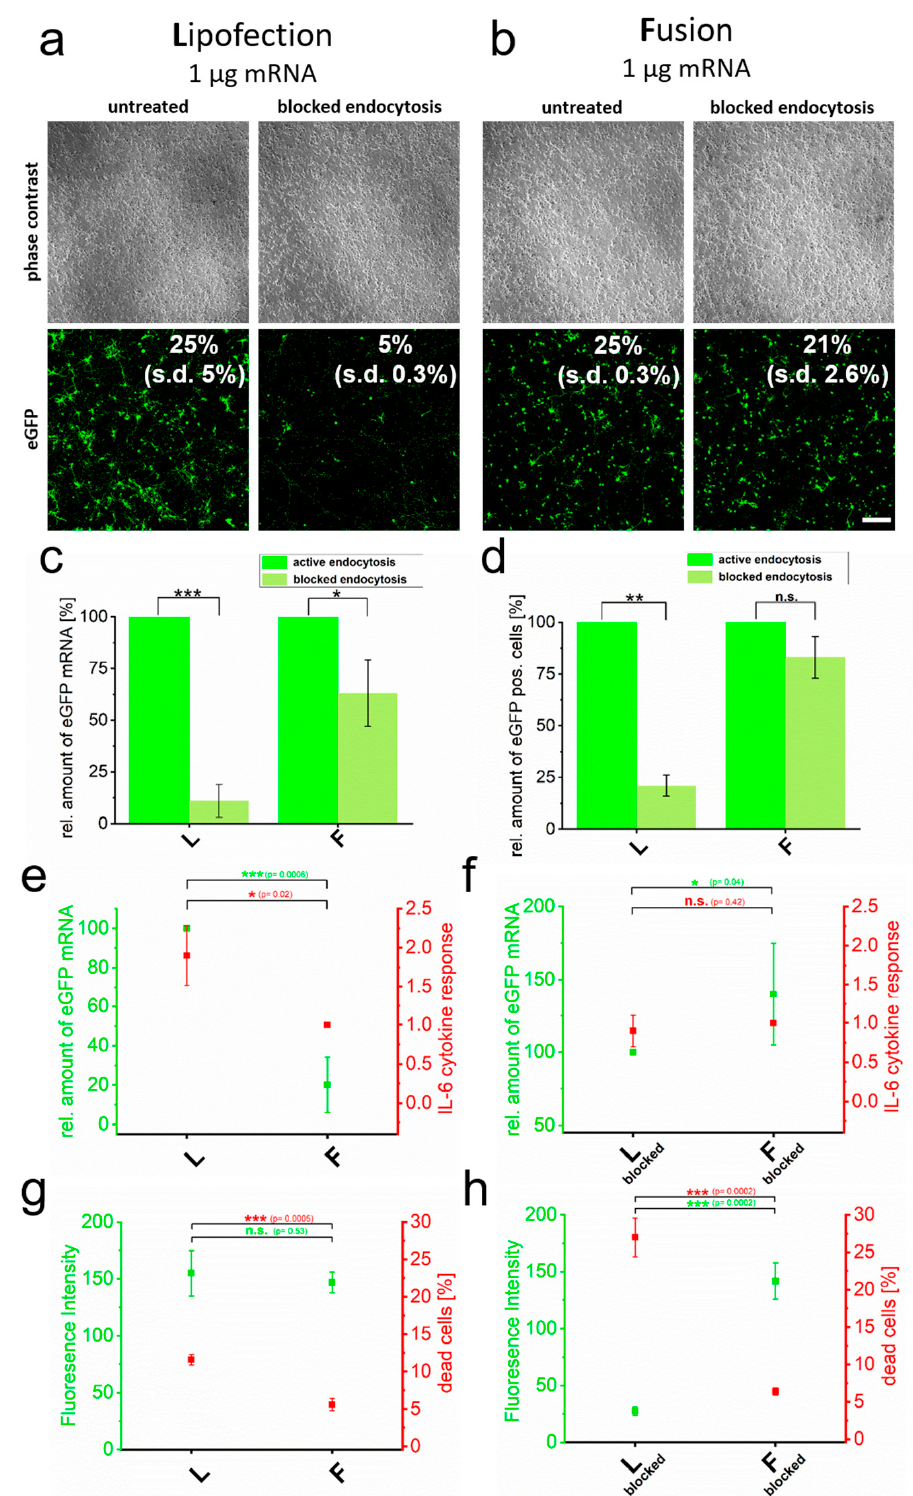
Figure 2. Cytotoxicity induced by RNA transfer is dependent on endocytic uptake. eGFP encoding mRNA was transferred into primary cortical neurons using endocytosis-dependent (lipofection, ( a )) and -independent (fusion, ( b )) transfection reagents. Transfer was performed in the absence and presence of endosome inhibitor β -MCD and cells were analyzed 24 h after treatment. Transfection efficiencies are indicated. Identically treated cells were analyzed for eGFP intensity by flow cytom- etry ( c ), relative amount of transferred eGFP mRNA (normalized to active endocytotic cells ( c , d ) and to the respective highest values of each measurement in ( e , f )) ( d ), IL-6 expression ( e , f ) and number of dead cells ( g , h ). For better comparison, IL-6 values are directly compared to transferred eGFP mRNA levels ( e , d ). Percentage of dead cells is given in comparison to fluorescence intensity ( g , h ). L= lipofection, F = fusion. eGFP-mRNA was used in a concentration of 4 µg/mL for fusion and 2 µg/mL for lipofection. In all cases, a total of 1 µg was transferred per substrate. Scale bar: 200 µm, n = three independent experiments for each analysis. p -values: not significant (n.s.): p > 0.05, *: p ≤ 0.05, **: p ≤ 0.01, ***: p ≤ 0.001.